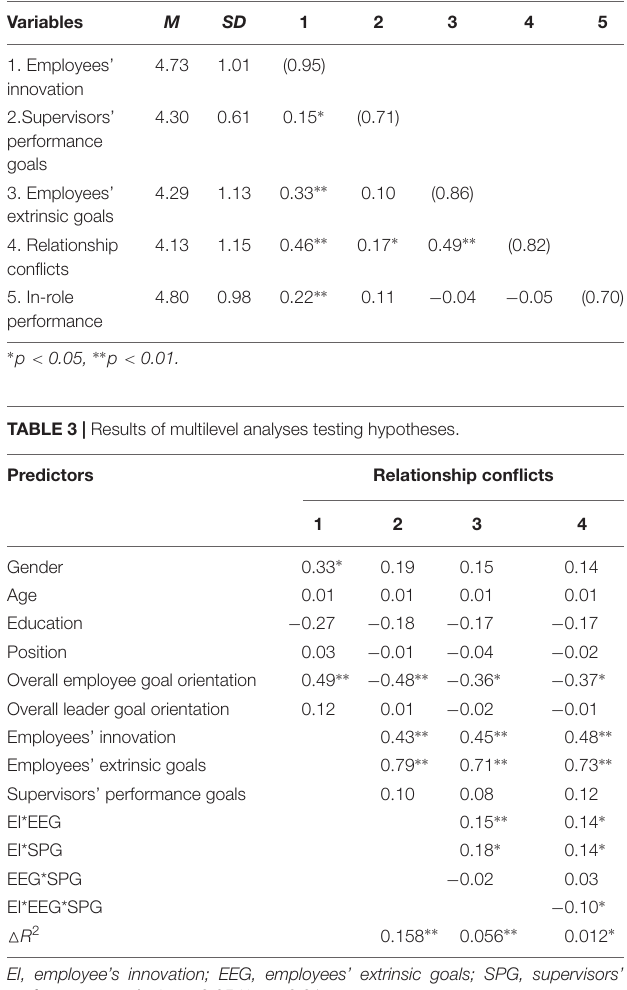
TABLE 2 | Correlations between variables.